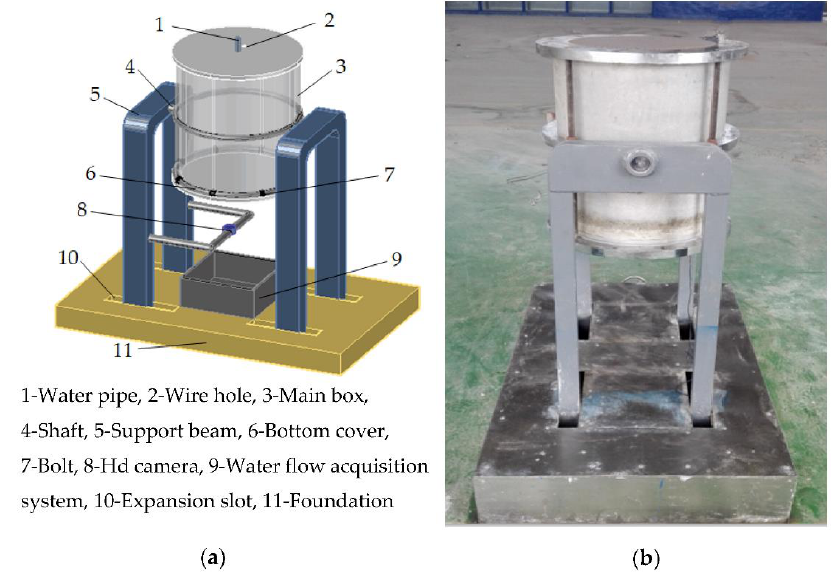
Figure 1. Multi-type water-inrush test system. ( a ) Design drawing of master system; ( b ) picture of real product.